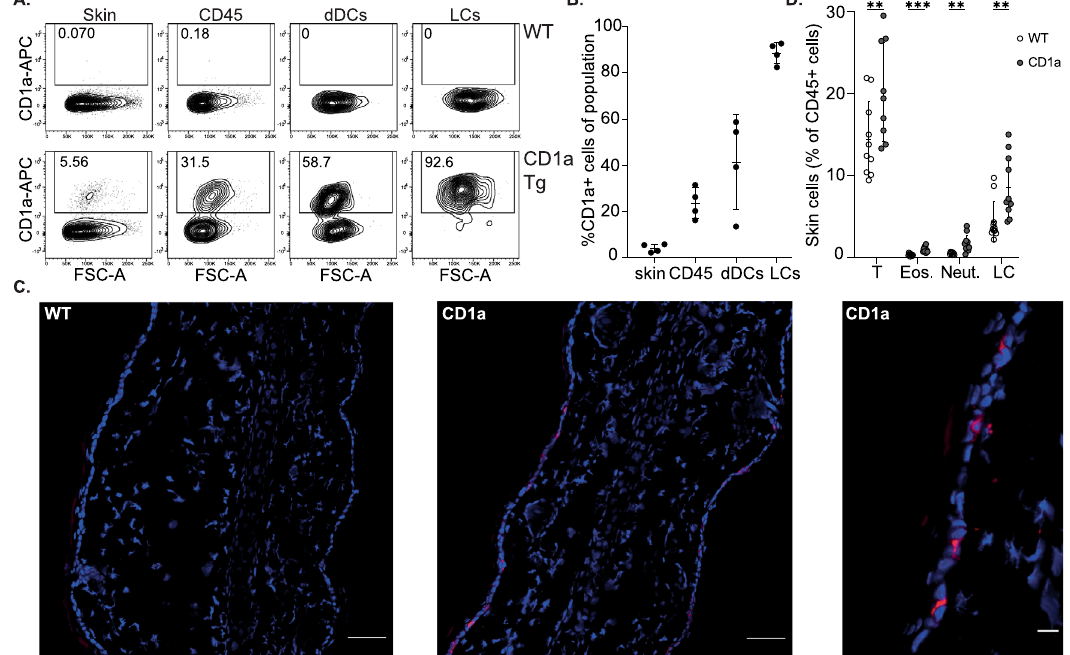
Fig. 1 | Characterization of CD1a transgenic mouse. A Representative fl ow cytometryplots and B graphicalsummaryofCD1a proteinexpressionbywild-type (WT) and CD1a transgenic (CD1a Tg) C57BL/6J mice. CD1a protein expression evaluated on (left-right) total live ear skin cells, CD45+skin cells, dermal dendritic cells (dDCs, CD45 + /CD11c + /langerin - ) and Langerhans cells (LCs, CD45 + /CD11c + /langerin + ). n =4 for all groups examined over 2 independent experiments. Mean±SD is shown. n represents biologically independent animals in each group. C CD1a protein expression within ear skin of wild-type (WT) and CD1a transgenic (CD1a) mice, visualized by immuno fl uorescence. Cryosections were stained with DAPI (blue) and anti-CD1a AF-594 (OKT6, red), scale bars left to right 50, 50 and